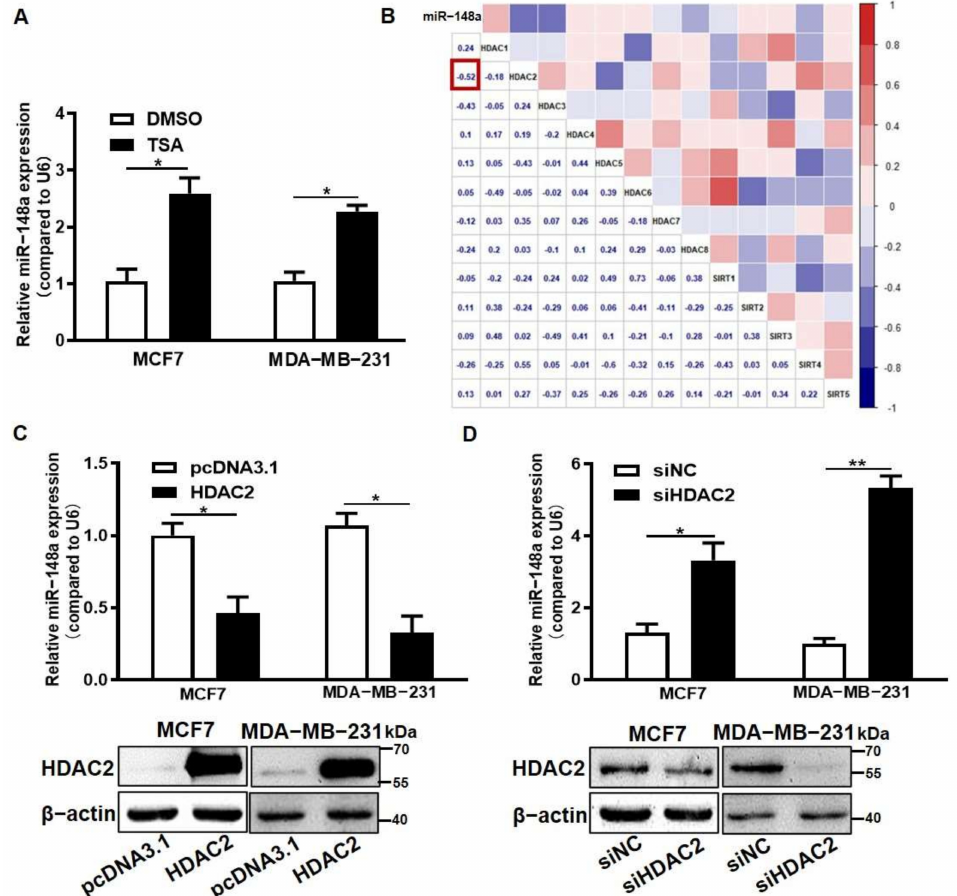
Figure 3. HDAC2 overexpression suppressed miR-148a expression. ( A ) MCF7 and MDA-MB-231 cells were treated with TSA or DMSO for 72 h. The expression levels of miR-148a were detected by qRT- PCR. ( B ) The correlations between miR-148a and histone acetylation modification-related proteins were analyzed (correlation: Pearson). ( C , D ) HDAC2 overexpression plasmid or HDAC2 siRNA were transfected into MCF7 and MDA-MB-231. After 48 h, miR-148a expression levels were detected in HDAC2 overexpression ( C ) or inhibition ( D ) groups by qRT-PCR. HDAC2 expression levels were detected by Western blotting. Data are shown as means ± SEM of three independent experiments in ( A , C , D ). Student’s t -test, * indicates significant difference at p < 0.05, and ** indicates significant difference at p < 0.01. Original Blots see Supplementary File